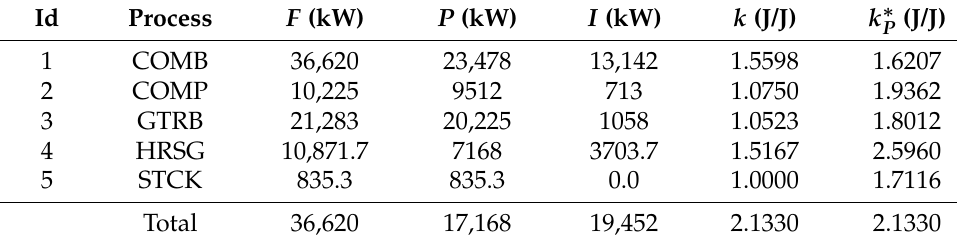
Table 4. Exergy balances and unit cost of TGAS